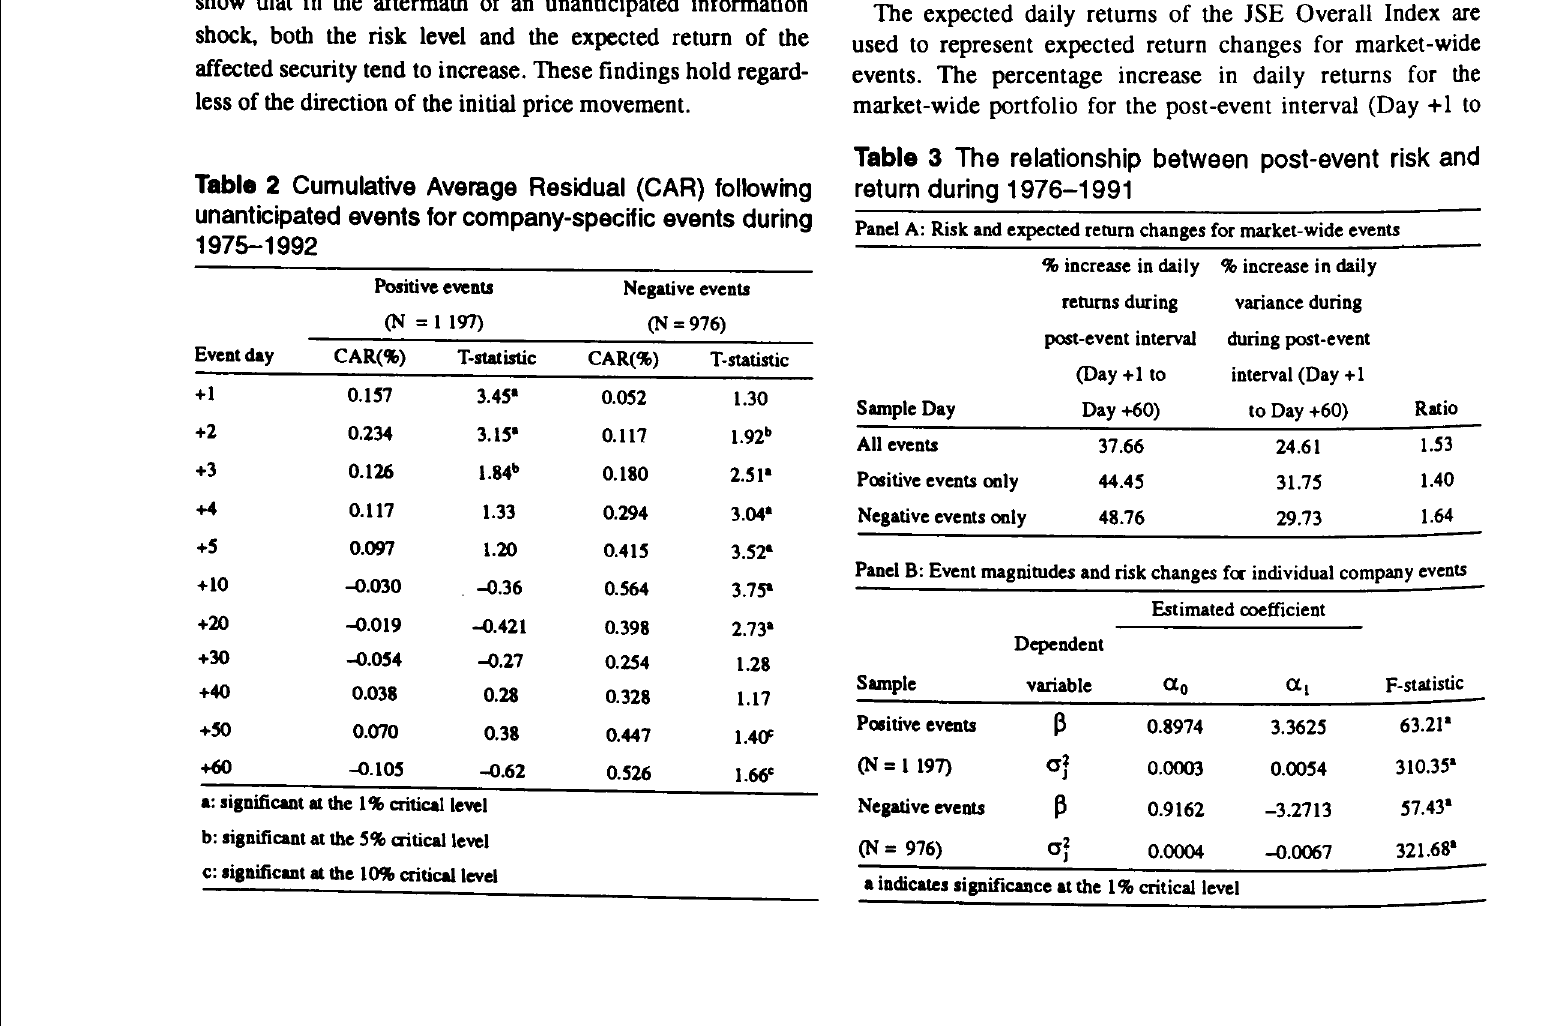
Table 2 Cumulative Average Residual (CAR} following unanticipated events for company-specific events during 1975-1992